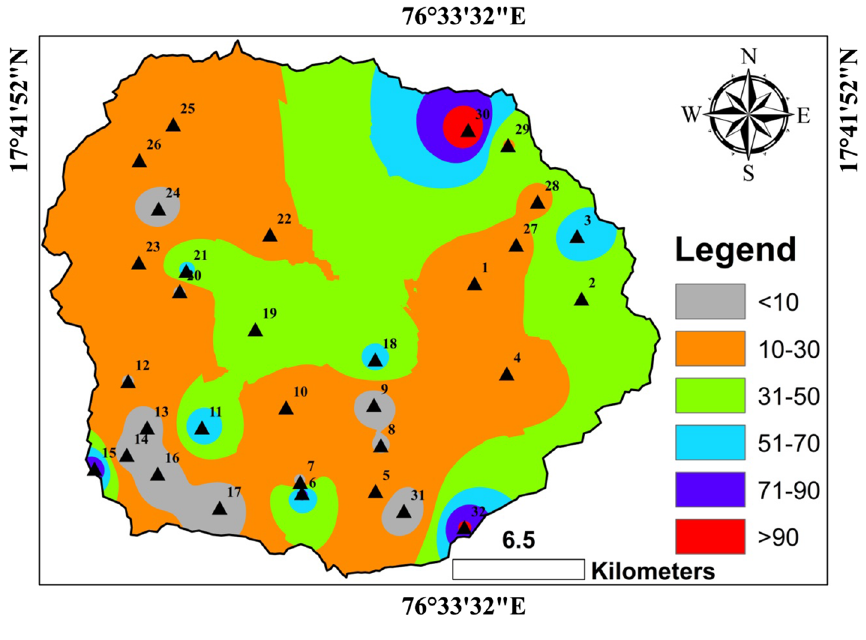
Fig. 11 Geospatial distribution of magnesium